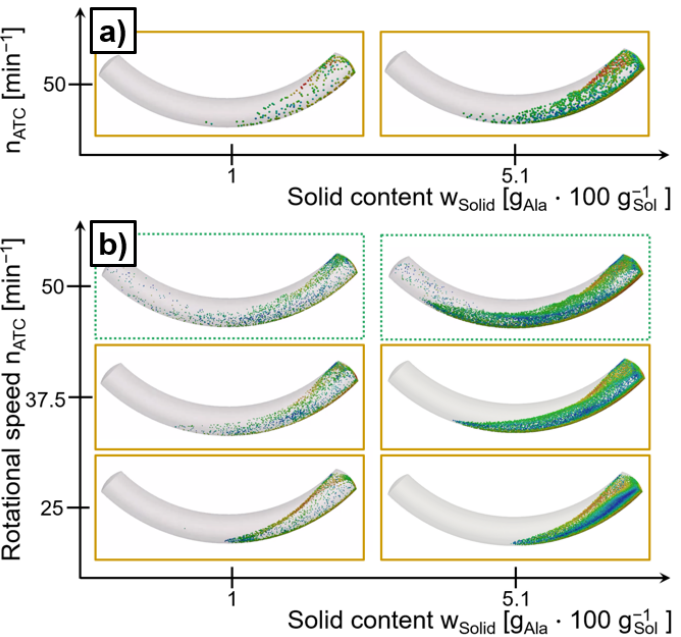
Figure 9. Suspension behavior observed in CFD simulations for ( a ) d p = 364 µ m and ( b ) d p = 182 µ m. Corresponding individual figures and accompanying videos are supplied in the Supplementary Material as ( a ) Figures S19 and S20 and ( b ) Figures